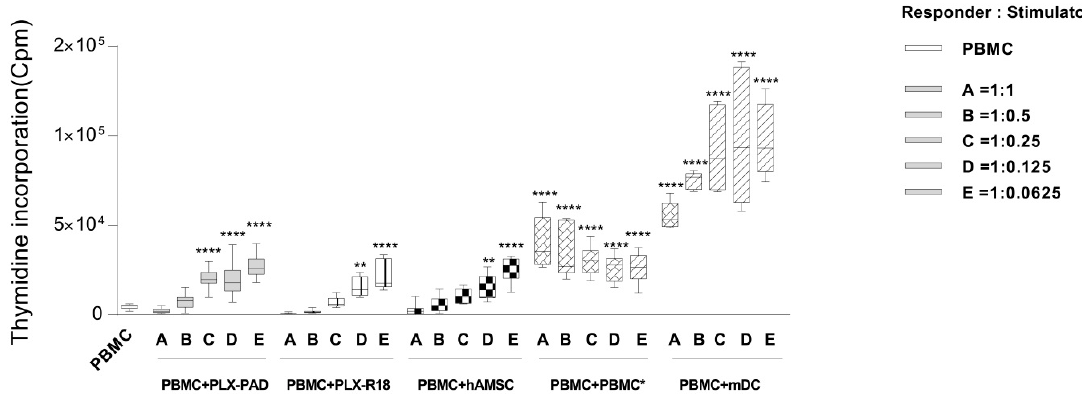
Figure 6. Immunogenicity of PLX-PAD cells. Responder PBMC (1 × 10 5 cells per well) were plated in a 96-round well plate and co-cultured with gamma irradiated (30Gy) stimulator: allogeneic maternal and fetal MSC (PLX-PAD, PLX-R18, and hAMSC), PBMC*, and mDC. Responder and stimulator cells were co-cultured at five different ratios (A = 1:1, B = 1:0.5, C = 1:0.25, D = 1:0.125, and E = 1:0.0625) and mixed lymphocyte reaction (PBMC*) and mature dendritic cells (mDC) were used as positive controls of a complete immune response/activation. PBMC proliferation was assessed by H 3 -thymidine incorporation and data are expressed as count per minute (cpm) (** p < 0.01, **** p < 0.0001 versus